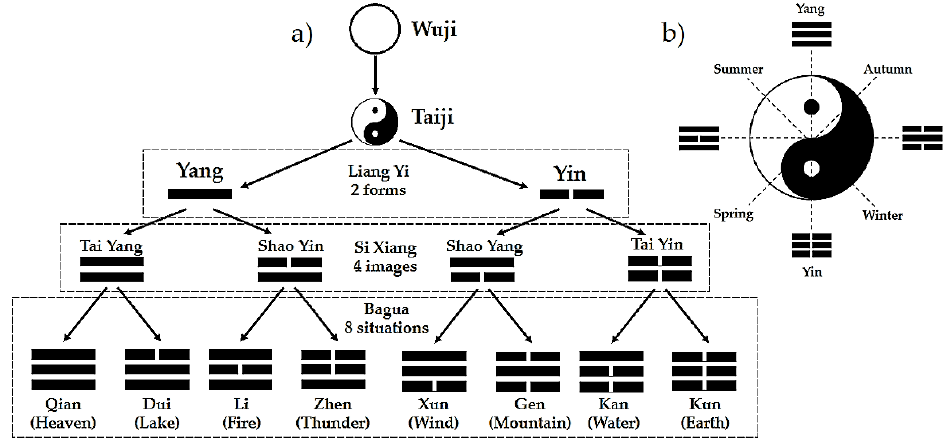
Figure 1. The creation of “yin yang” and “Bagua” ( a ); the “Taiji” symbol ( b ).